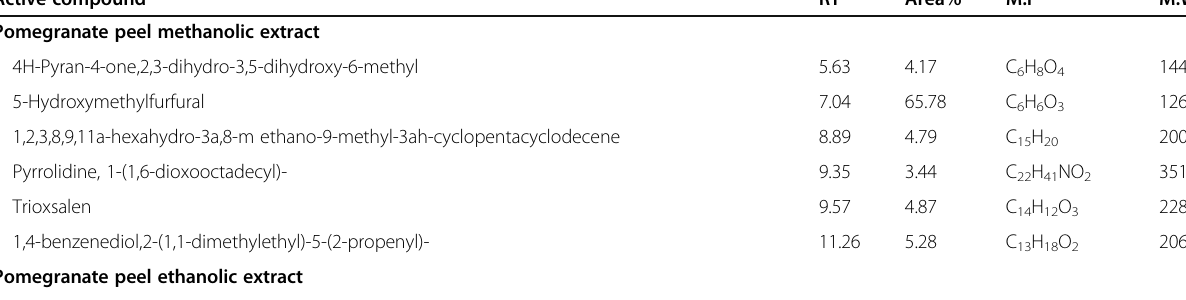
Table 5 The most abundant chemical compounds in extracts of pomegranate peels by GC-MS analysis Active compound